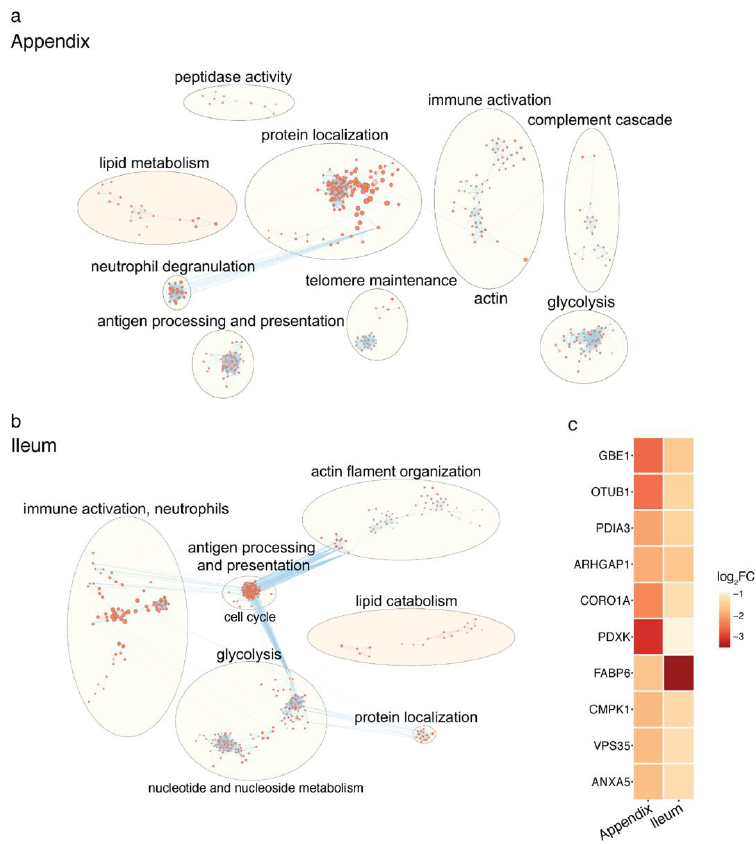
Figure 2. Proteomic analysis identifies the altered lipid metabolism pathways in the PD appendix and ileum. Pathway enrichment analysis of proteomic changes in the PD appendix relative to controls ( n = 3 PD, 3 controls) ( a ) and in PD ileum relative to controls ( n = 4 PD, 4 controls) ( b ). Pathway analysis of quantitative proteomic data was performed using g:Pro- filer. Nodes are pathways altered in the PD appendix that were clustered into functionally similar networks by Enrich- mentMap (nodes are q < 0.05 pathways, hypergeometric test). Node size represents the number of genes in the pathway gene set, and the edges connect pathways with similar gene sets (0.7 similarity cutoff). The lipid metabolism pathway network is highlighted in peach. ( c ) Top 10 proteins that were most consistently altered in the PD appendix and ileum. Heatmap showing the proteins ranked as the most consistently disrupted in the PD appendix and ileum, as determined by a robust ranking algorithm. Log fold change is shown, and red signifies greater disruption in PD.